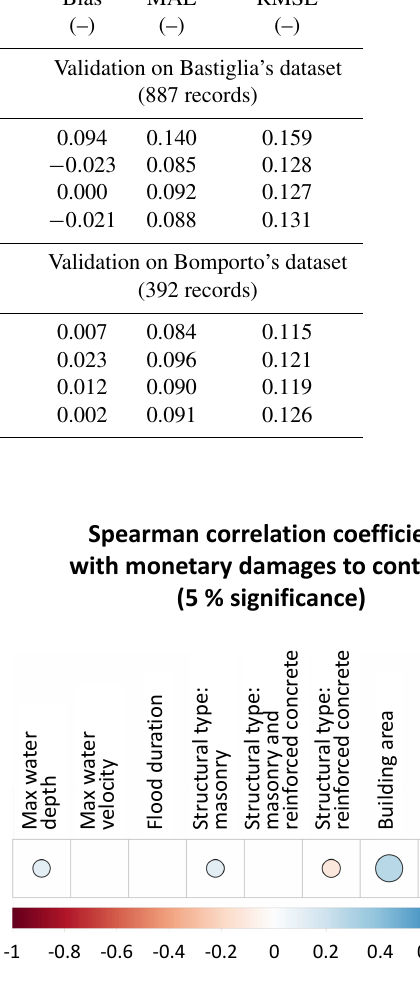
Figure 11. Spearman correlation between monetary loss (contents only) and predictive variables: maximum water depth, maximum water velocity, flood duration, structural type (masonry, masonry and reinforced concrete, or reinforced concrete), building area, building value per unit area and monetary loss to buildings. Empty boxes indicate statistically nonsignificant correlation coefficients at a 5% significance